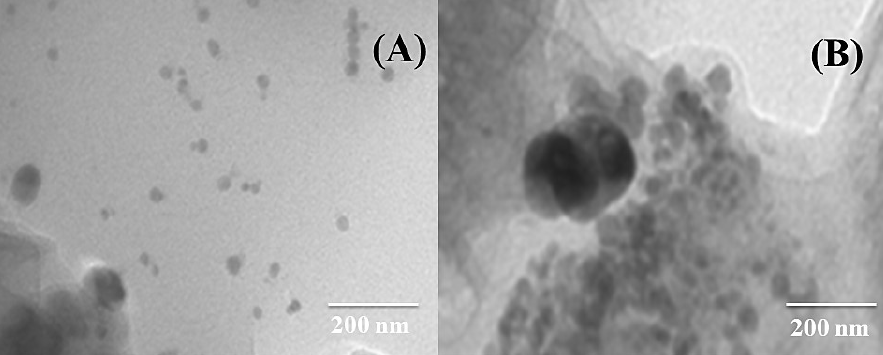
Figure 2. TEM images of CuAg/rGO ( A ) and CoAg/rGO ( B ) electrocatalysts. SEM images of CuAg/rGO and CoAg/rGO electrocatalysts with corresponding EDS spectra and mapping are presented in Figure 3. SEM images of CuAg/rGO and CoAg/rGO (Figure 3A,C) show a uniform distribution of metal nanoparticles (bright parts) over rGO (gray parts). Corresponding EDS spectra and mapping (Figure 3B,D) show the presence of Ag, Cu, Co, C, and O elements and confirm their uniform distribution.